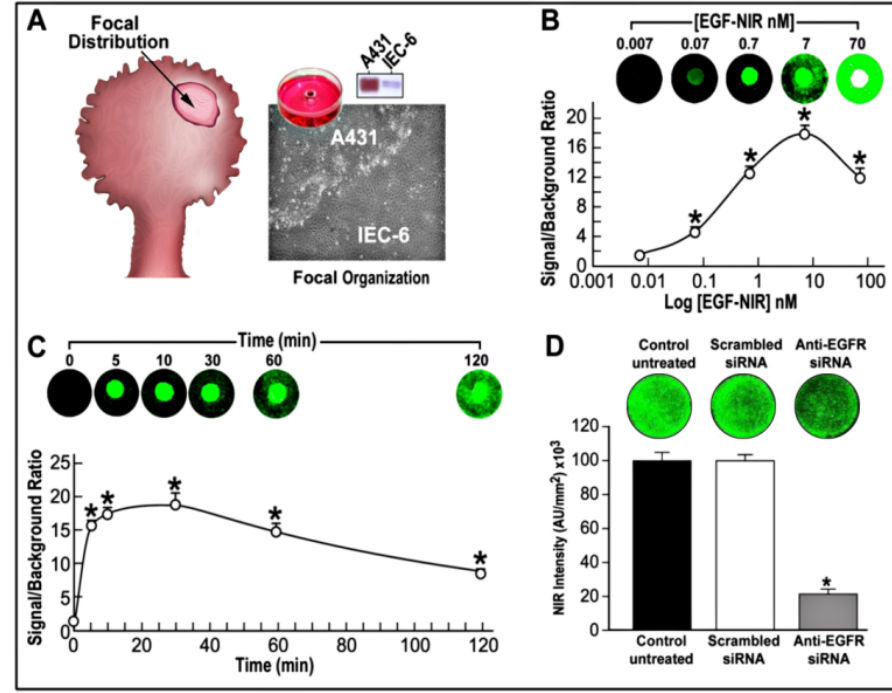
Figure 2. NIR bio-imaging of EGFR expression level in a focal model of A431 cells. ( A ) Left: CRC polyp scheme displaying high spots of transformed CRC cells (focal distribution); Right: focal plating (in a ring) of A431 monolayer surrounded by IEC6 enterocytes monolayer; Insert: Western blotting of EGFR protein in equal amounts of cell protein extract; ( B ) The relationship between the signal/background ratio (mean ± SD, n = 9) and EGF-NIR concentration. Insert: NIR scans; * p < 0.05 vs. 0.007 nM; ( C ) The kinetics of 7 nM EGF-NIR binding to the cell cultures (mean ± SD, n = 9); Insert: NIR scans; * p < 0.05 vs. 0 min; ( D ) siRNA induced knock down of EGFR measured by EGF-NIR bio-imaging. Homogenous monolayer cultures of A431 cells were transfected for 2 days with 5 nM anti EGFR Silencer select siRNA, or scrambled siRNA, or left untreated (control). Thereafter, EGFR expression was evaluated by NIR bio-imaging after incubating the cells with 7 nM EGF-NIR. The NIR imaging was estimated at the following conditions: resolution: 170–340 microns; pixel area: 0.03 mm 2 ; quality: medium-low; focus offset: 3; channels: 800 nm; intensity: 1; * p < 0.05 vs. scrambled or